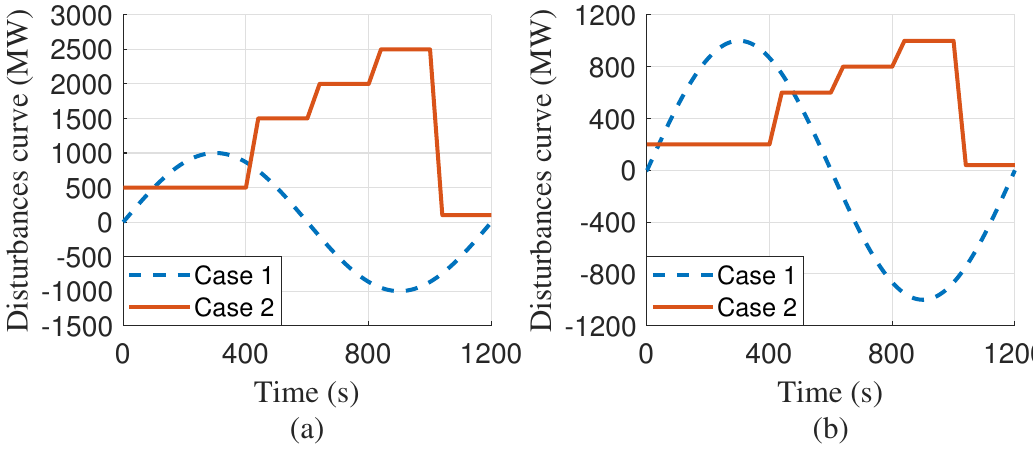
Figure 8. Curves of large continuous disturbances: ( a ) two-area power system; ( b ) three-area power system; and China Southern Power